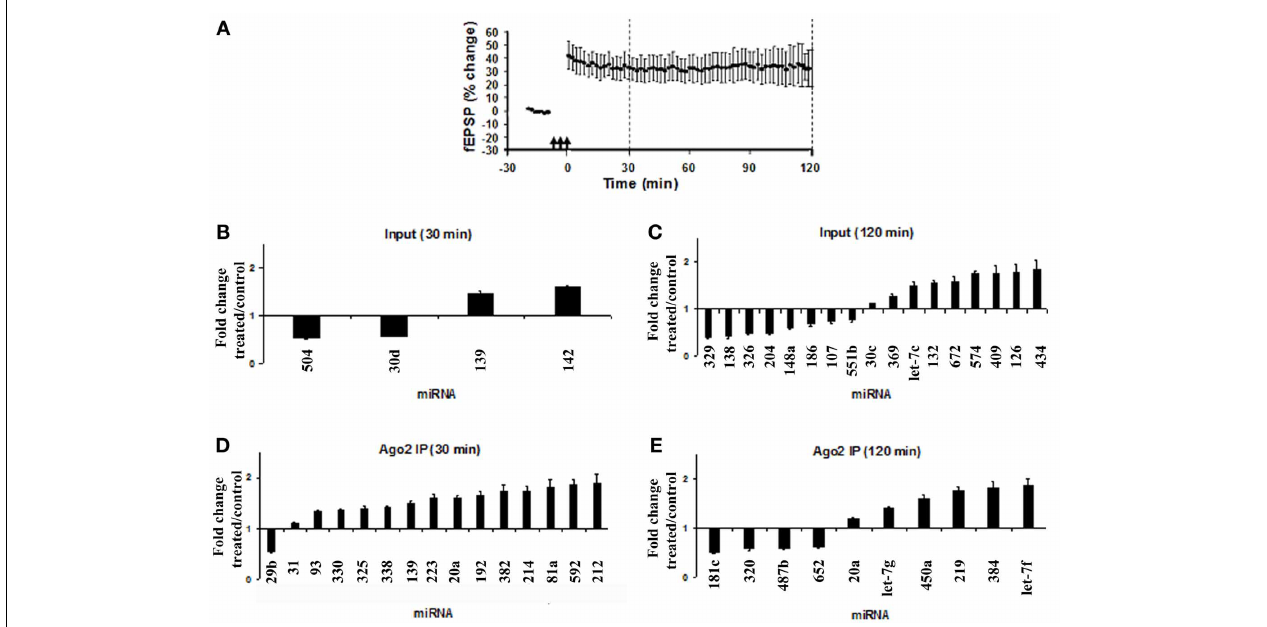
FIGURE 2 | Modulation of miRNA expression in total lysates and Ago2 immunoprecipitates following LTP induction. (A) Time course plot showing changes in the medial perforant path-evoked fEPSP slope expressed as a percentage of baseline. Values are mean ± s.e.m. ( n = 3). Dentate gyrus tissue was obtained at 30 or 120min post-HFS. (B–E) miRNA PCR cards from Exiqon were used to screen 373 miRNAs in total lysates (input) and Ago2 immunoprecipitates following high-frequency stimulation (HFS). Data for input and Ago2 IP samples for each time point were normalized to the respective global mean of all